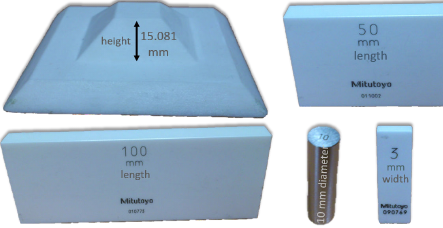
Figure 1. Gauges used to measure the error of different optical measurement